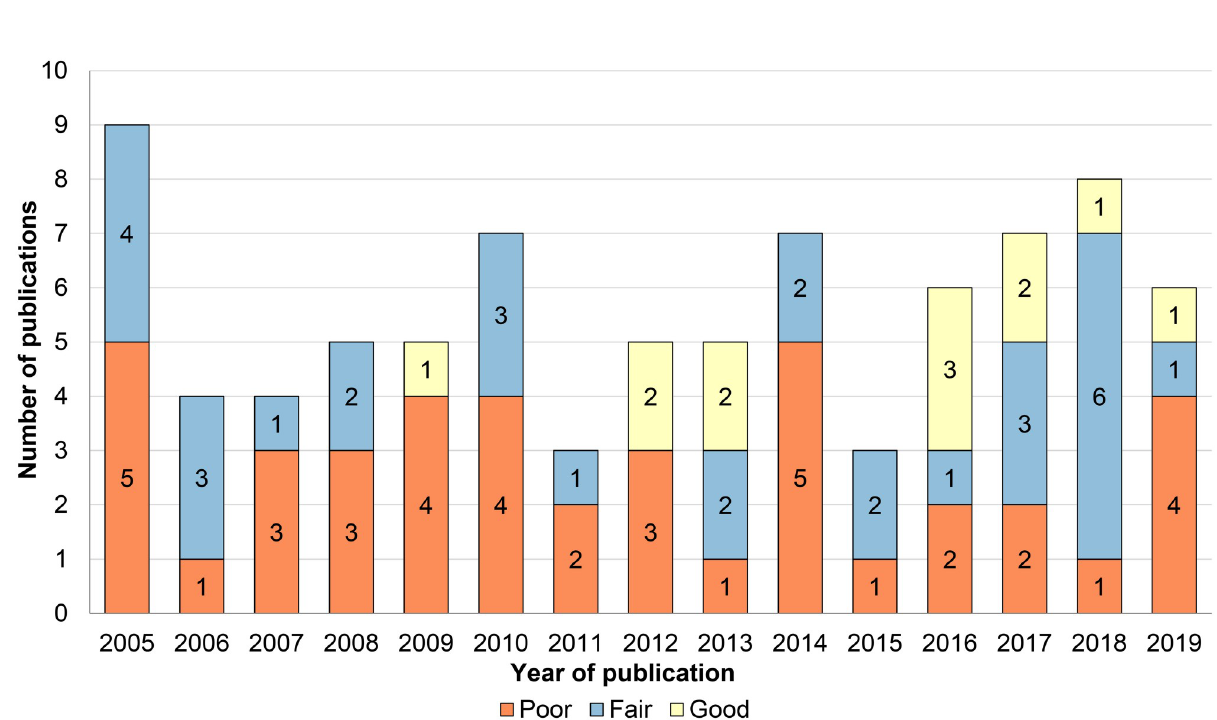
Fig 6. Trends in quality of published studies. The stacked columns show the absolute annual number of published studies stratified by Downs and Black checklist scores. The year 2020 (N = 1 ‘good’ quality study) was omitted because it is incomplete. No studies of ‘excellent’ quality were found.